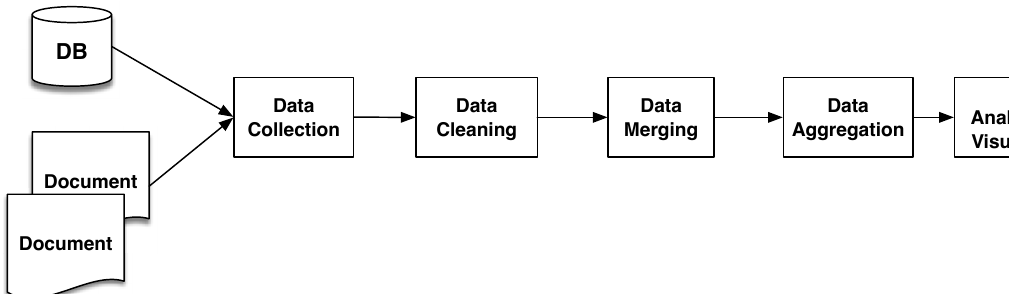
Figure 3. The main modules of COVID-WAREHOUSE analysis pipeline. Data Collection allows to store the downloaded raw data locally. Data Cleaning provides ETL methods based on RE, enabling the cleaning, replacing and deletion of special characters present into the raw data, that can compromise the next steps and analysis. Data Merging uses cleaned data to produce the Reconciled Table. Data Aggregation yields a condensed version of the DW called Data Mart obtained from the Reconciled Table, from which to obtain the multidimensional cubes. Data Analysis and Visualization allows to perform statistical analysis and Heatmap visualization on the predefined